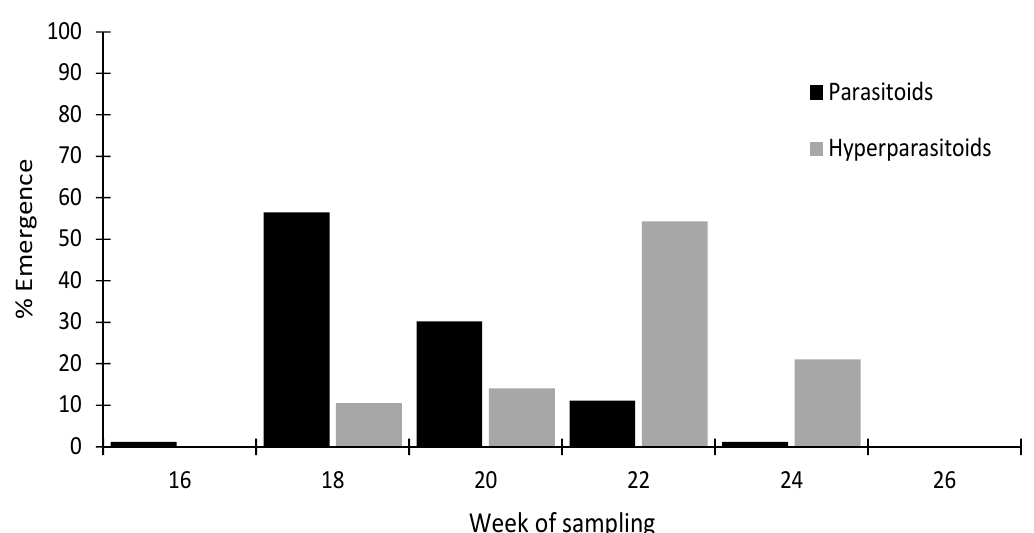
Figure 1. Bi-weekly seasonality of M. persicae parasitoids and hyperparasitoids from sentinel plants. The percentages of parasitoids and hyperparasitoids per sampling date were calculated based on the total number of parasitoids and hyperparasitoids, respectively, that emerged from aphid mummies.